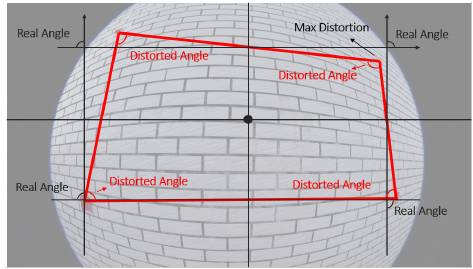
Figure 3. The explanation of distortion